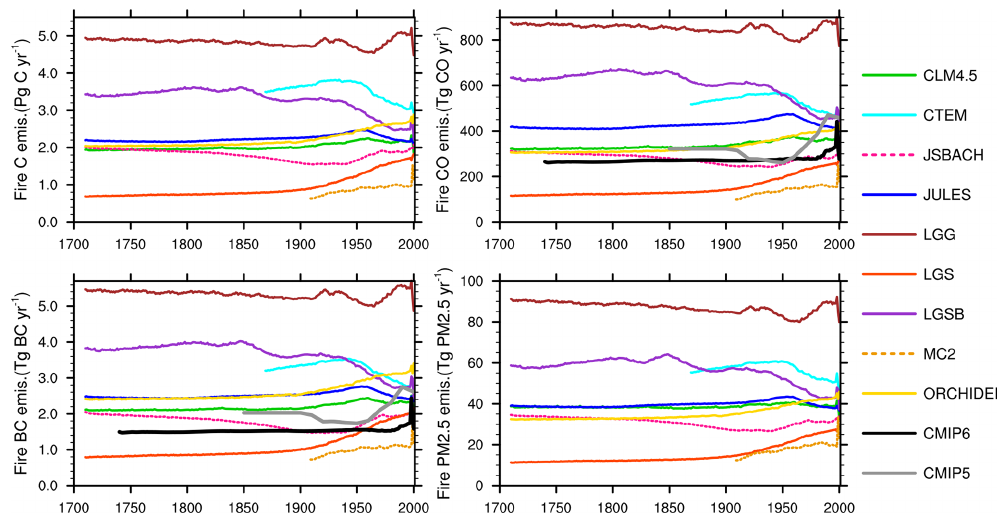
Figure 6. Long-term temporal change in fire emissions from DGVMs in FireMIP and CMIP forcing. A 21-year running mean is used.